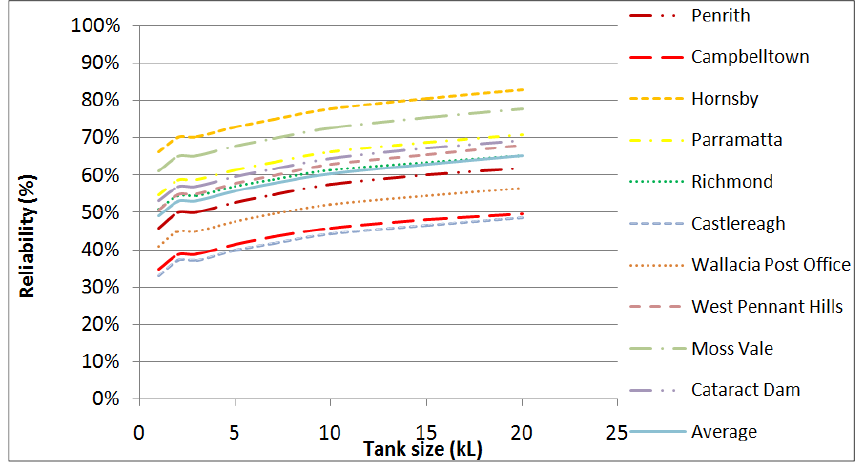
Figure 4. Reliability of RWHS at ten selected locations using rainwater for irrigation use (considering the daily rainfall data of all the years on record).